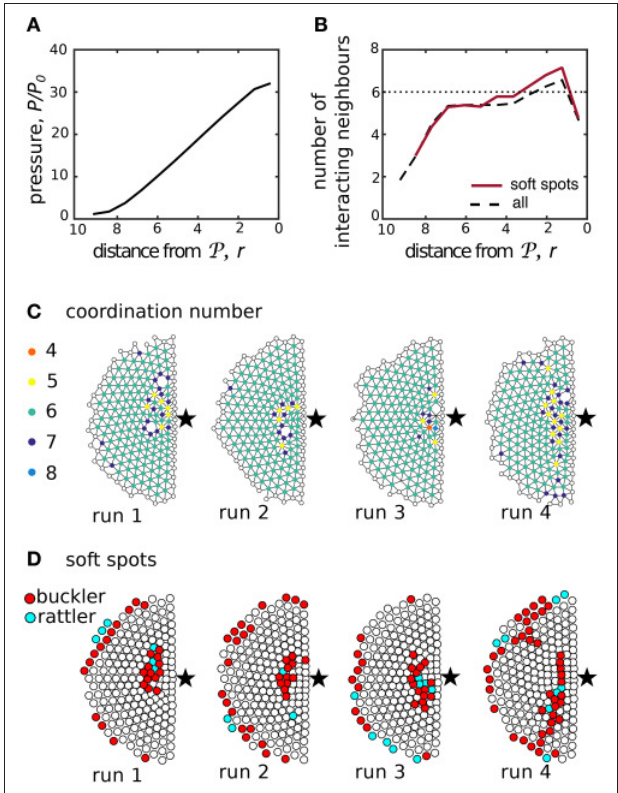
FIGURE 12 | Local coordination number correlates with soft spots. (A) The µ v 0 (2 π r 0 ) − 1 reveals a gradient average radial pressure normalized by P 0 = within the aggregate. This pressure drives deviations (B) from homogenous hexagonal packing as measured by the average number of interacting neighbors at a distance r from the point of interest P . Hexagonal close packings of hard disks have six interacting neighbors, which is added as a dashed line for reference. (C) The local coordination number, shown here for 4 runs, can be computed from a snap shot of the system. Comparison with (D) shows the coordination number strongly correlates with the location of soft spots, which are found through more lengthy computations involving the identification of aggregated bucklers (red).